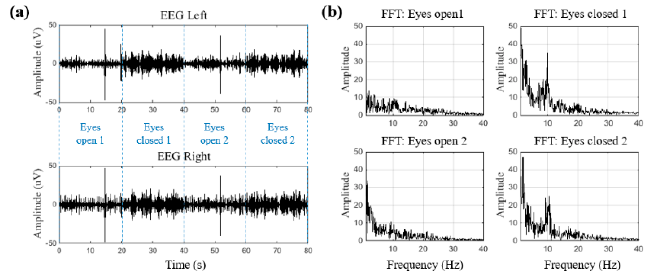
Figure 8. The alpha wave test: ( a ) EEG waveform of the eyes-open and eyes-closed sessions, and ( b ) power spectra of the eyes-open and eyes-closed sessions.